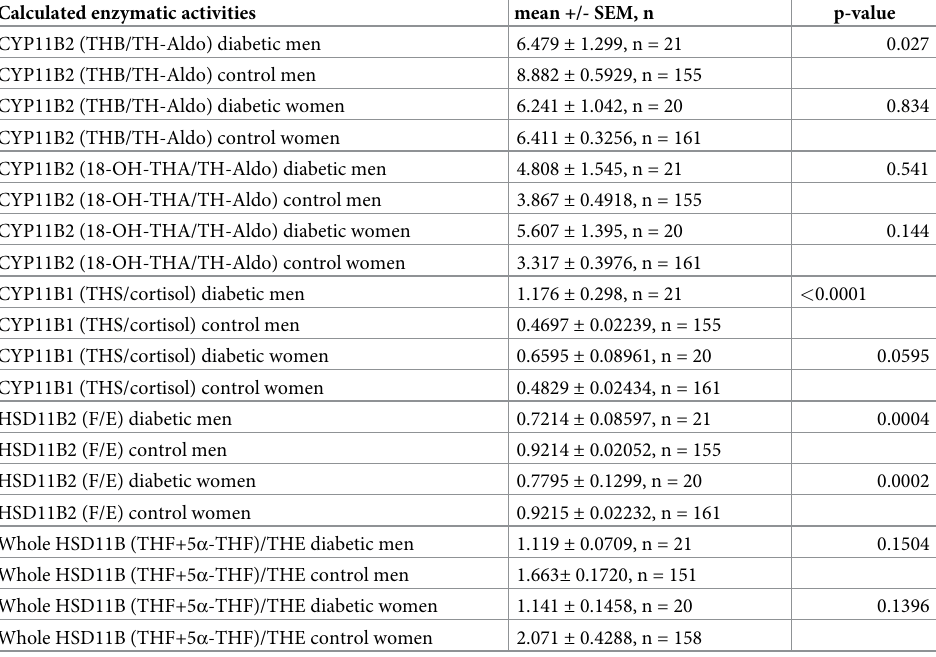
Primary HRMC in Fig 7 were cultured for 72 in high glucose conditions (25.55mM). Medium was renewed every 24h. After the 72h priming period, HRMC were stimulated for additional 24h with aldosterone (10 -7 M) or cortisol (10 -7 M) and with the combination of aldo- sterone or cortisol with spironolactone (10 -6 M) and RU486 (10 -6 M) in steroid free medium (charcoal treated MCM) containing high glucose levels (25.55mM). EtOH was the solvent. It is displayed in the baseline control. The MR and GR inhibitors spironolactone and RU486 respectively were added 1h prior to the steroid hormones, in order to allow binding to the receptors before challenging the cells with the ligands. Table 3. Absolute values of the calculated enzymatic activities of the two human